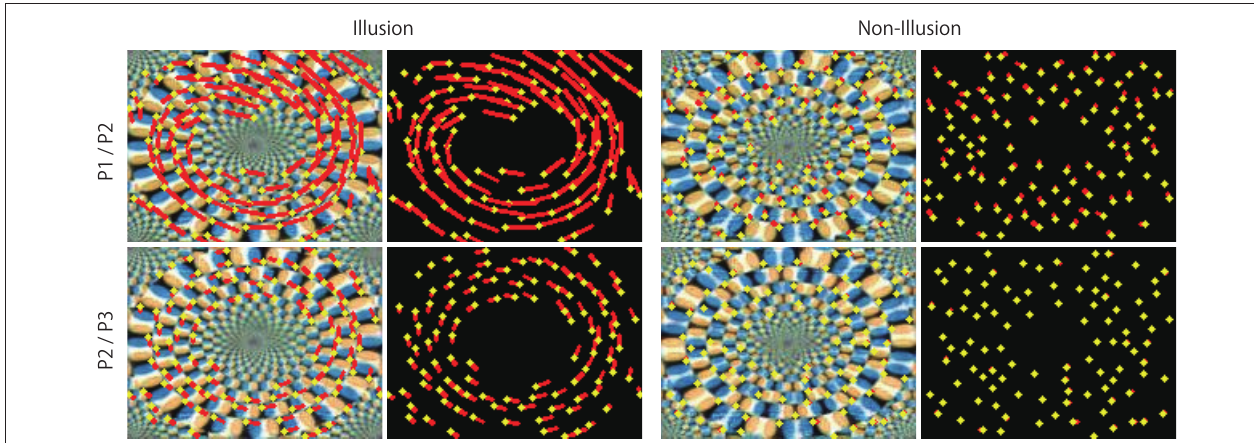
FIGURE 9 | Optical flow vectors detected in the illusion. Optical flow vectors detected between a pair of consecutive predictive images (P1/P2 or P2/P3) of the illusion. The magnitude of the vectors was amplified 60 times. The left is a single ring of the rotating snake illusion, and the right is a negative control image. The vectors were imposed over the P2 or P3 images or black background (width 160, height 120 pixels). A network trained with 500K video frames was used for prediction.